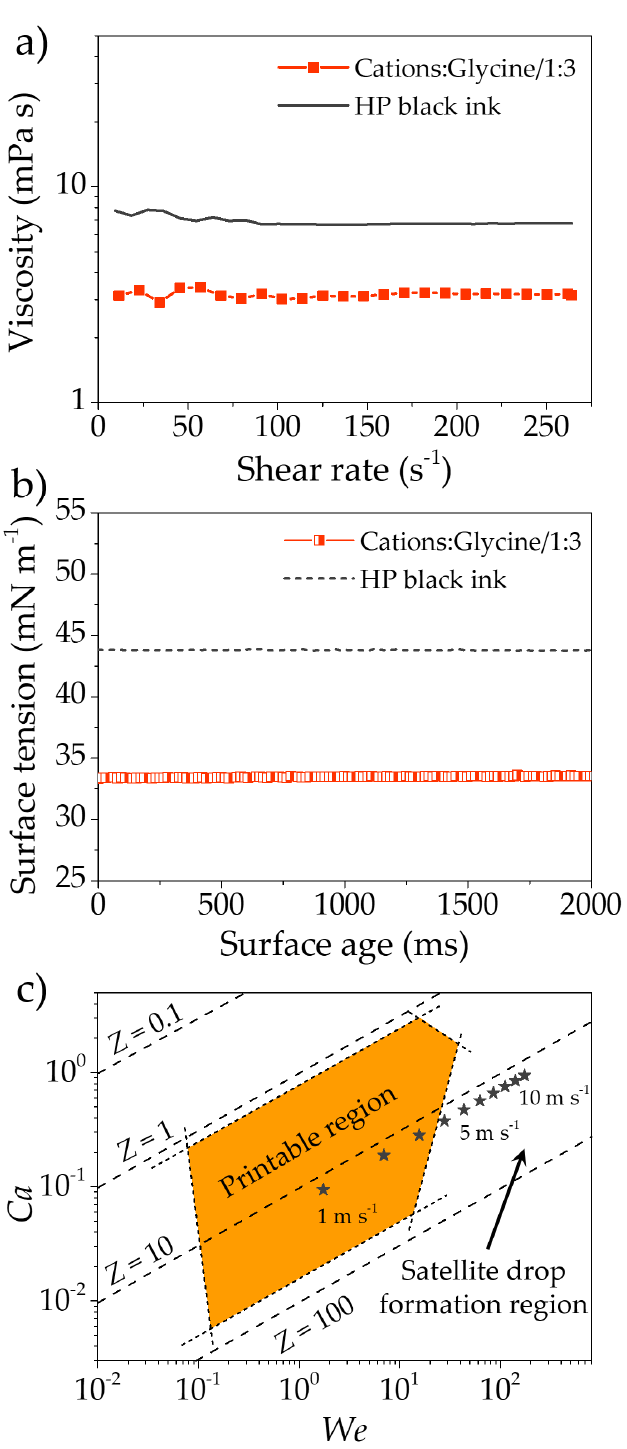
Figure 1. Viscosity ( a ) and surface tension ( b ) measurements of the sol-gel ink compared with the HP ink inside the cartridges [86]. ( c ) Printable region for IPJ deposition. The black stars represent the formulated ink considering the velocity range of the drops (1–10 m s −1 ). The ink is between the preferable region for jetting and the satellite drop region. Panel ( c ) was adapted with permission from H. C. Nallan, J. A. Sadie, R. Kitsomboonloha, S. K. Volkman, and V. Subramanian, Langmuir 30, 13470 (2014). Copyright 2014 American Chemical Society.